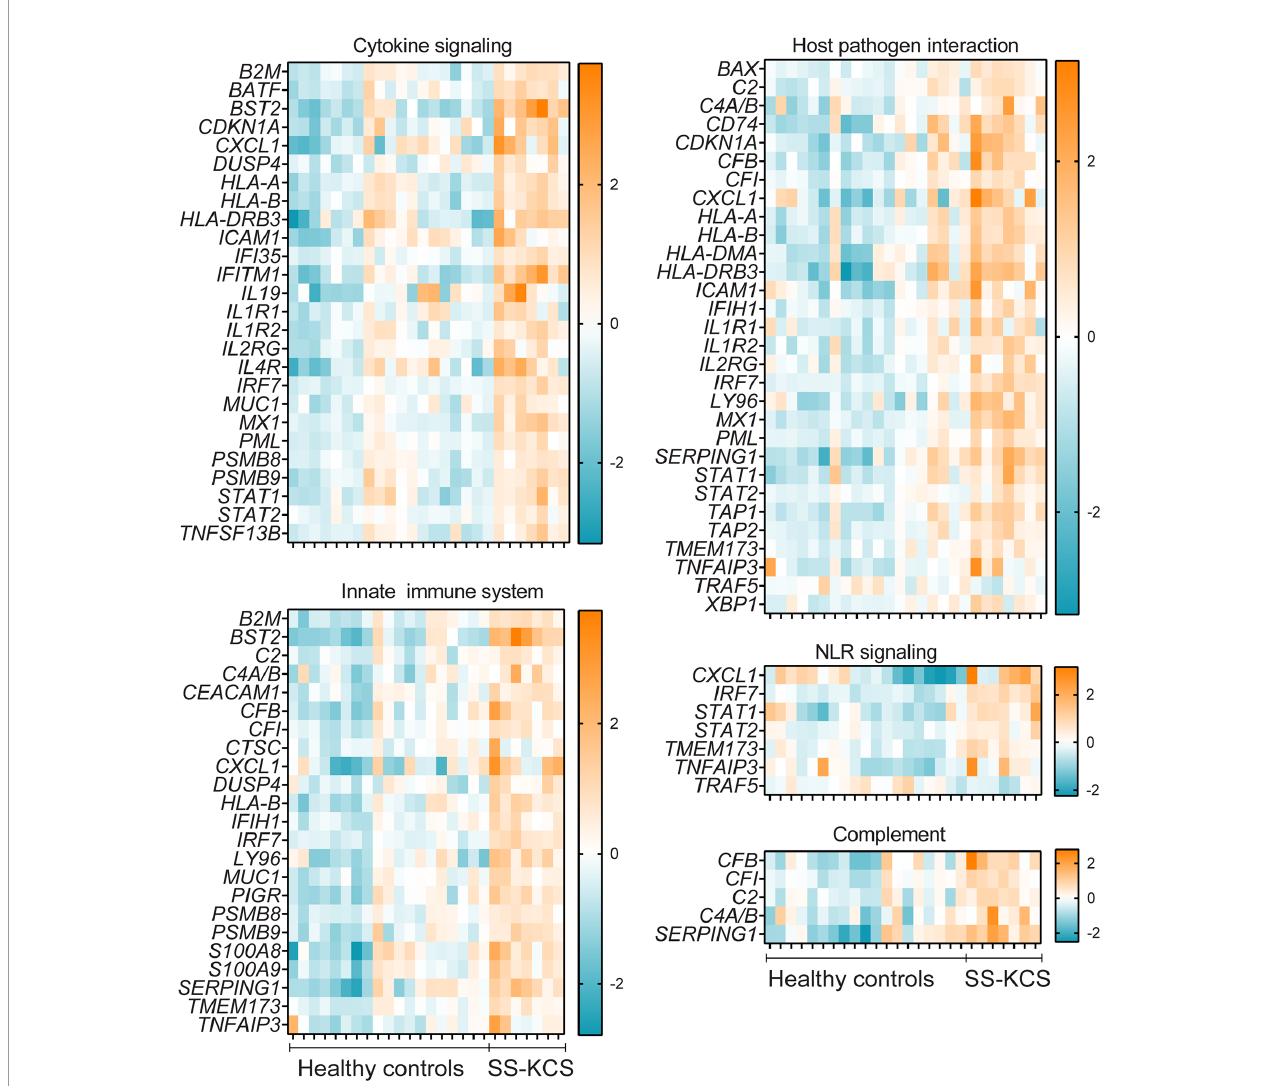
FIGURE 3 | Heatmaps of expression of immune pathways with signi fi cant genes upregulated or downregulated gene ( TRAF5 ) in SS KCS conjunctiva. Heatmaps show Cytokine signaling, Host-pathogen interaction, Innate immune system, Nod-like-receptor (NLR) signaling, and Complement